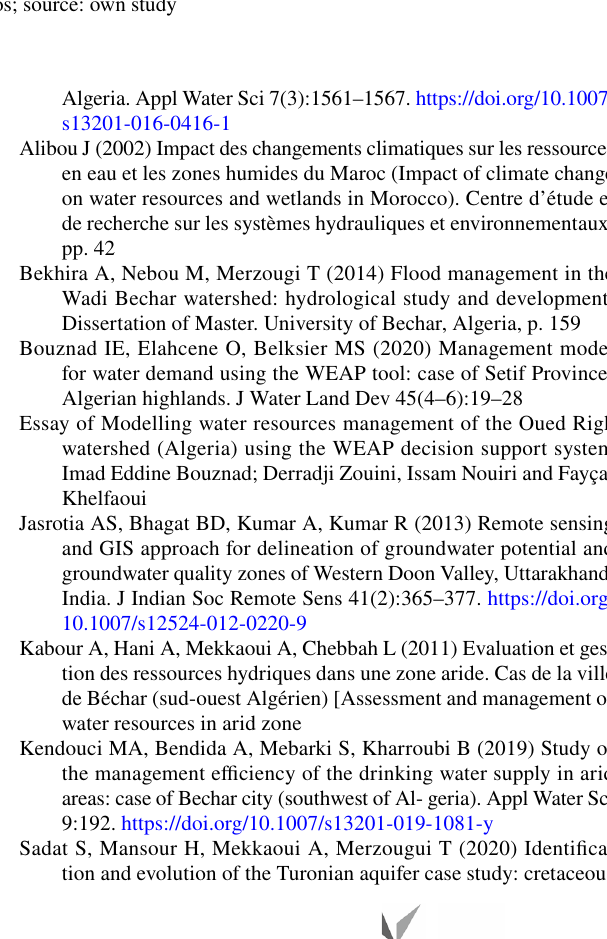
Fig. 8 Evolution of unmet water demand in the Bechar city—all scenarios; source: own